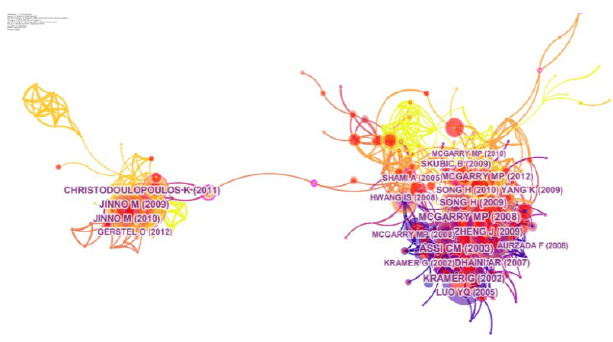
Figure 2. Document Co-Citation Analysis Results